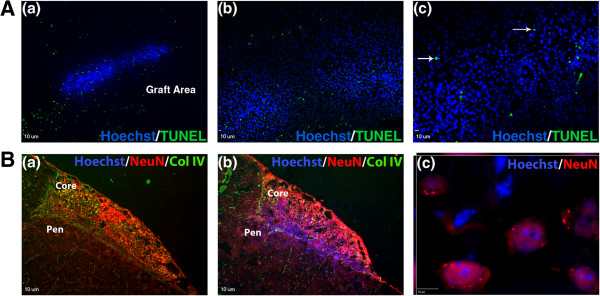
hES cell-derived neural precursors survive and differentiate into neurons in vivo. (A) Representative example of graft survival 2 days after transplantation. The circle in (a) marks the graft area as determined by the Hoechst-tagged precursor cells. Arrows in (c) demonstrate occasional TUNEL co-localization with Hoechst-positive cells. (B) Representative images stained for NeuN (red) and collagen IV (green) 28 days after transplantation. No Hoechst-positive cells (blue) are evident in the medium control animal (a), whereas many transplanted cells are still present in the transplant animal (b). The high-power image in (c) demonstrates co-localization of Hoechst 33342 and NeuN in the penumbra region, indicating neuronal differentiation of transplanted cells. All scale bars = 10 μm.